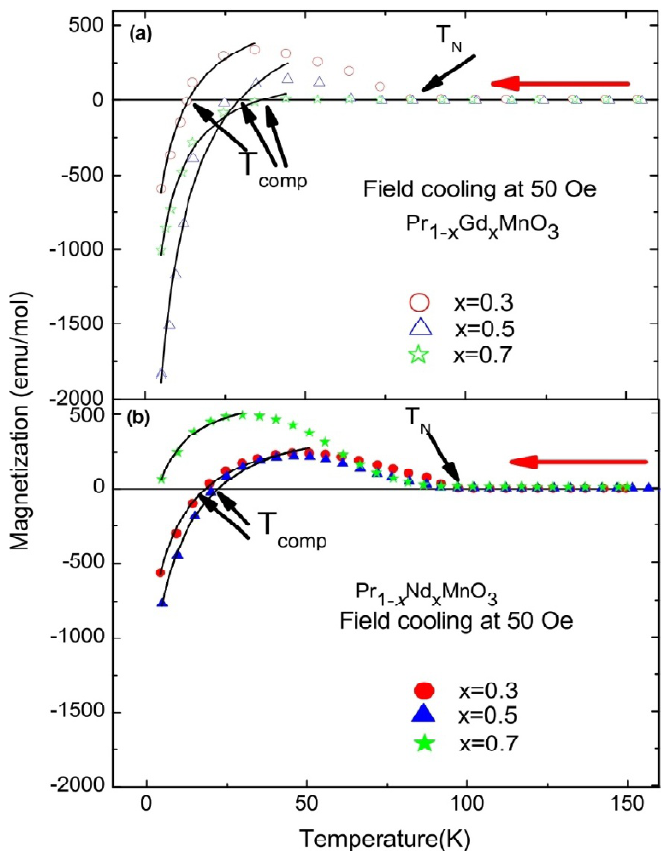
Fig. 9. DC temperature dependent magnetization curve in FC mode of (a) Pr and (b) Pr Nd MnO ( x =0.3, 0.5, 0.7). Solid line shows fitting using Eq. (1) of M – T data recorded under 1- x x 3